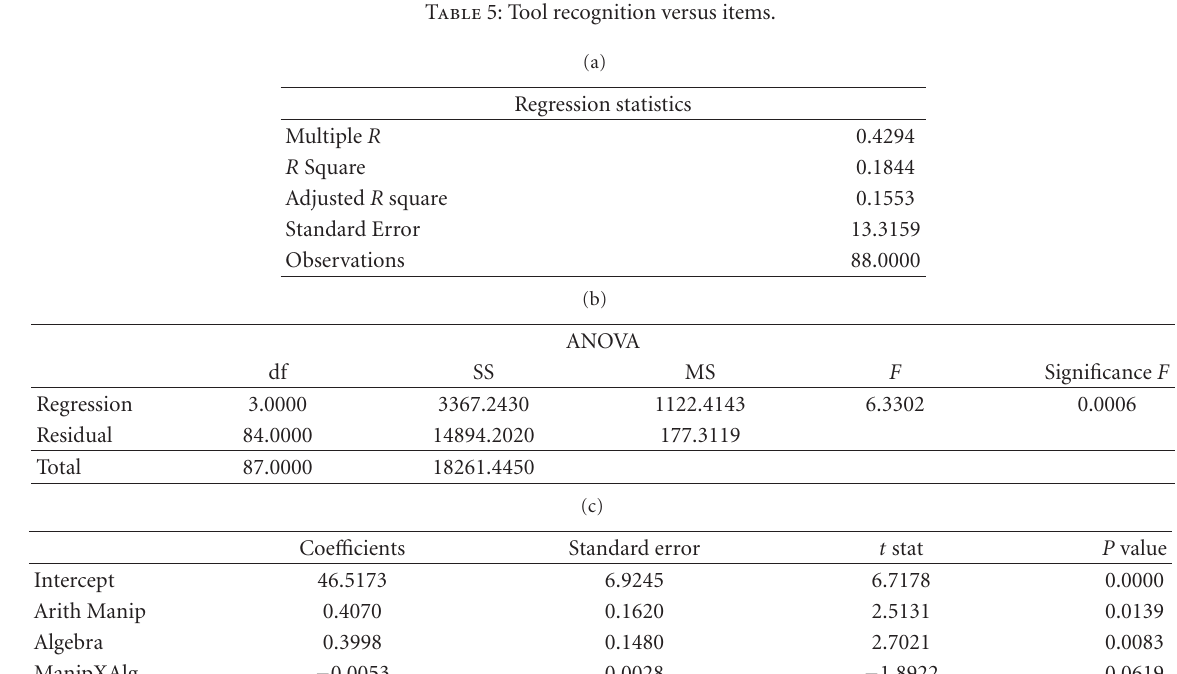
Table 5: Tool recognition versus